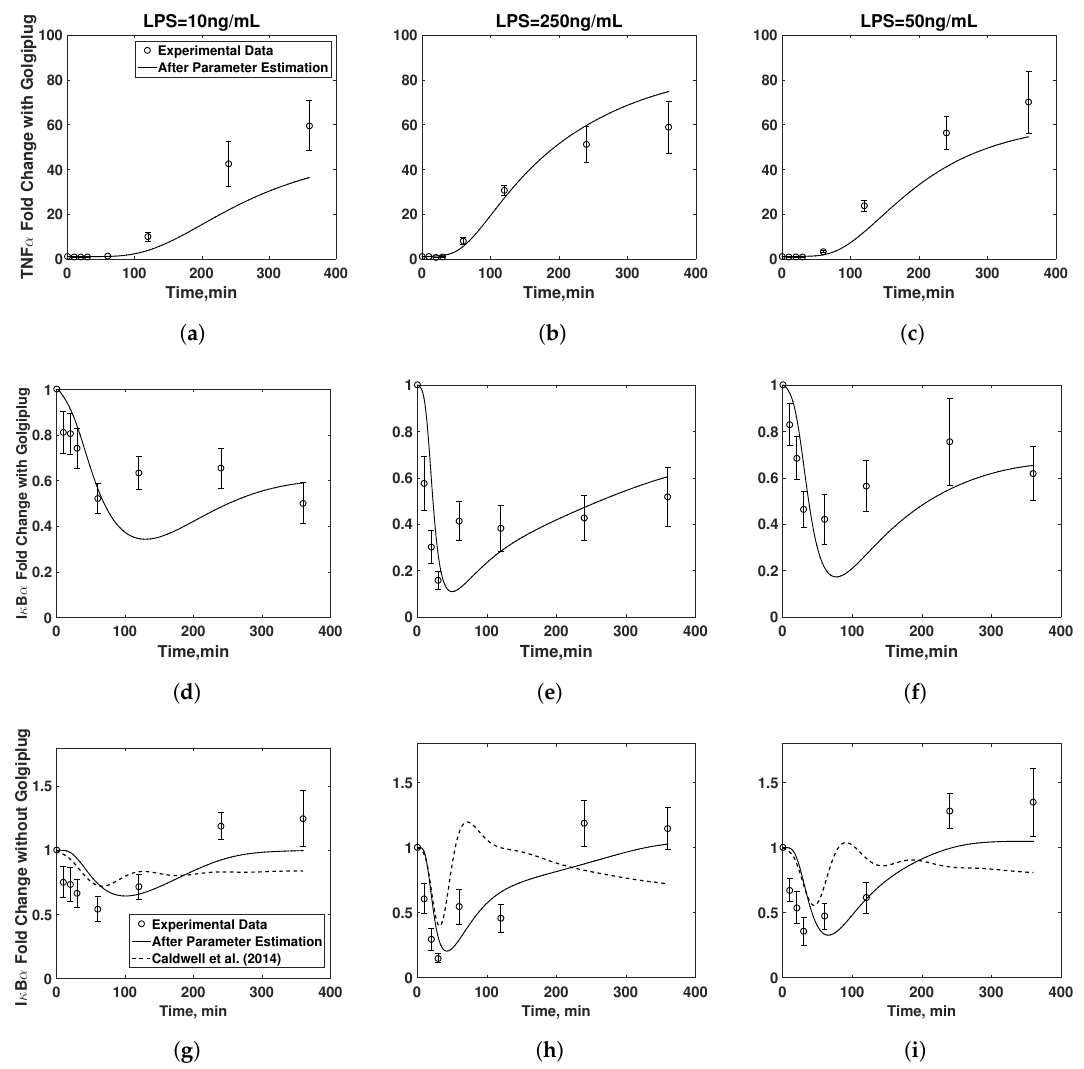
Figure 4. Parameter estimation considering Golgiplug ™ -induced ER stress. ( a – c ) Measured (empty circle) and simulated (solid line) fold changes of intracellular TNF α concentrations over time were plotted in the presence of Golgiplug ™ . ( d – f ) Measured (empty circle) and simulated (solid line) fold changes of I κ B α concentrations over time were plotted in the presence of Golgiplug ™ . ( g – i ) Measured (empty circle) and simulated (solid line) fold changes of I κ B α concentrations over time were plotted in the absence of Golgiplug ™ . The I κ B α dynamics predicted by the model in [21,24] were also plotted in ( g – i ) for comparison. Indicated amounts of LPS were used for experiments and